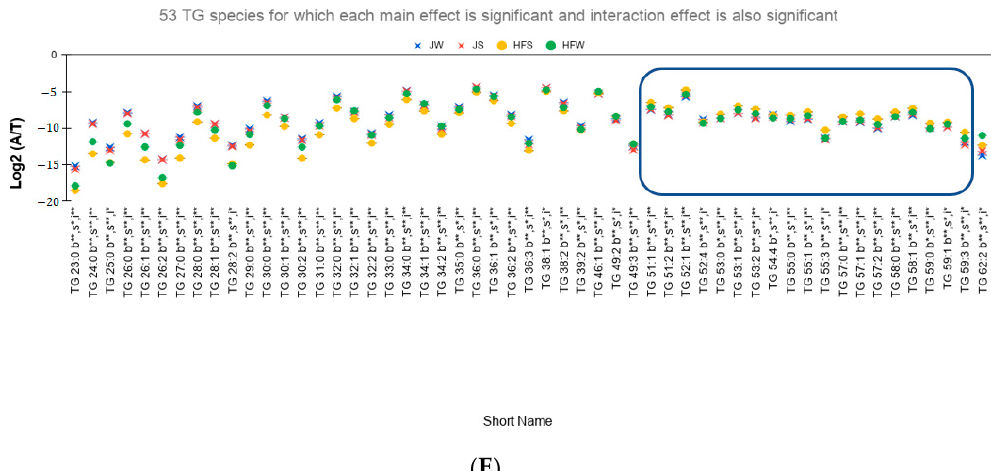
Figure 3. ( A ) Variation of the lipid profile of bovine milk: Each marker is the mean value of 15 J buffalos and 15 HF cows. Suffixes to the lipid composition: b, s, and i followed by ** ( p < 0.01) and * ( p < 0.05) as represent the statistical difference between the breeds, seasons, and interaction respectively. The reported p -values were calculated using Two-Way ANOVA with replication. A: normalized ion abundance of an analyte; T: total ion abundance of all the analytes belonging to the same subclass. 91 TG species showed statistically significant variations due to the interaction e ff ect and at least one of the main e ff ects. ( B ) 47 significant TG species with higher seasonal variation in HF samples than in J samples. The su ffi x phHF * and phHF ** represent Tukey’s HSD test p -value < 0.05 and p -value < 0.01 respectively for testing whether there is a significant variation between the seasons for the HF samples. ( C ) Only 27 TG species i.e., 19% of the reported TG species have statistically non-significant variation between the breeds. ( D ) 58 TG species do not vary significantly between the seasons. ( E ) 53 TG species have significant interaction e ff ect as well as significant variations between the breeds and the seasons. TG species inside the rectangle ( A , B , E ) have higher relative abundances in summer season. Note that Standard Error for each group is used as the error bar.